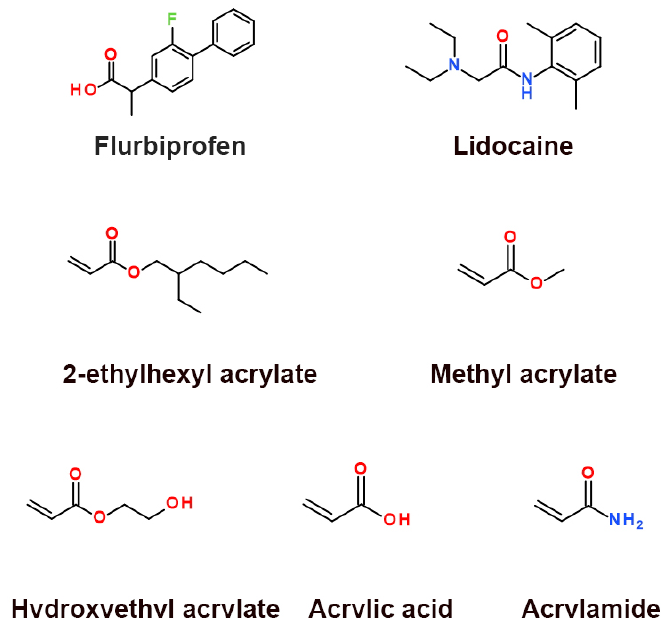
Figure 1. Chemical structures of model drugs and monomers (the chemical structures were obtained from the PubChem database).